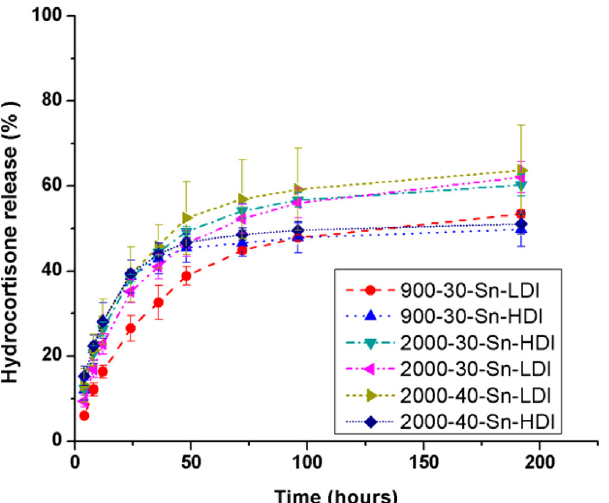
TABLE I - Number-average molecular weight ( M PEEUs